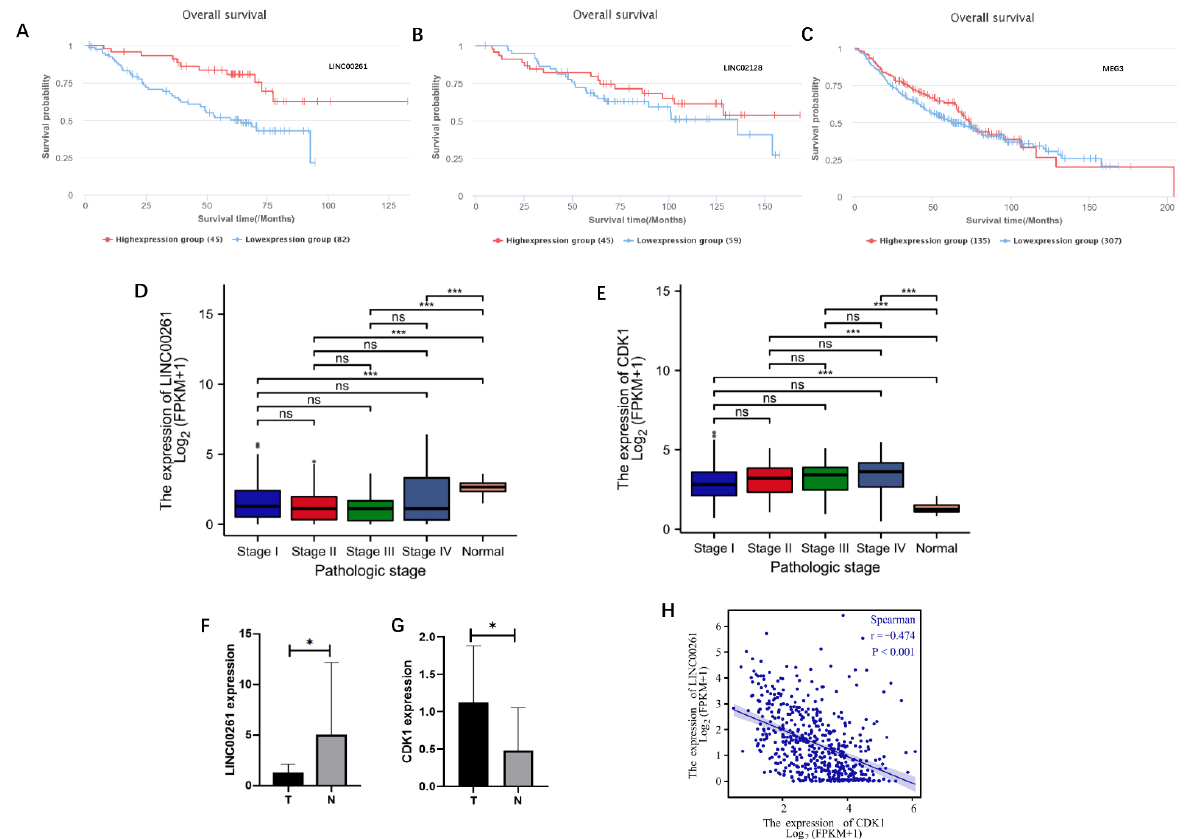
Figure 3. Identification of Hub-lncRNA. ( A – C ) Survival analysis of lncRNAs in LUAD. The data are from the LUAD project in TCGA database. ( A ) LINC00261, ( B ) LINC02128, and ( C ) MEG3. ( D , E ) LINC00261 ( D ) and CDK1 ( E ) expression in normal tissues and LUAD with different stages. The data for analysis were from the LUAD project in TCGA database. Significance markers: ns, p ≥ 0.05; * p < 0.05; *** p < 0.001. ( F , G ) The expression differences of LINC00261 ( F ) and CDK1 ( G ) in LUAD and normal tissues were verified by RT-qPCR. Significance markers: ns, p ≥ 0.05; * p < 0.05; *** p < 0.001. ( H ) Correlation analysis of CDK1 and LINC00261. The data for analysis were from the LUAD project in TCGA database.